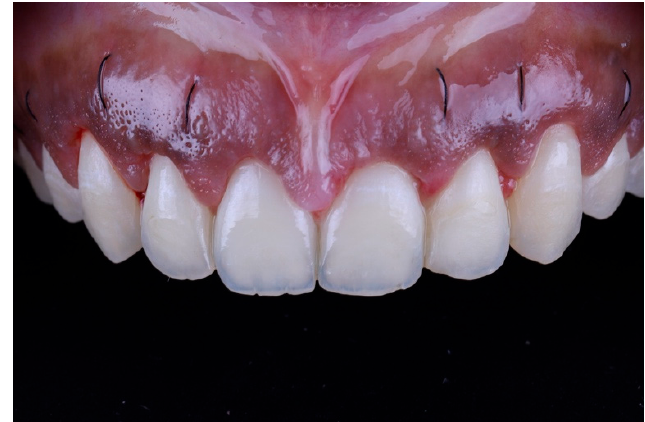
Figure 9. Bone level after osteoectomy and osteoplasty.